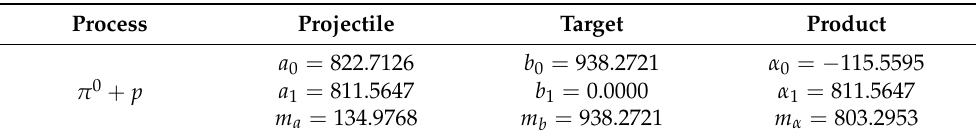
Table 2. Case BBT calculation (in MeV/ c 2 with c set to 1) with Equations (49) and (50) satisfied up to four digits after the decimal shown. See text for